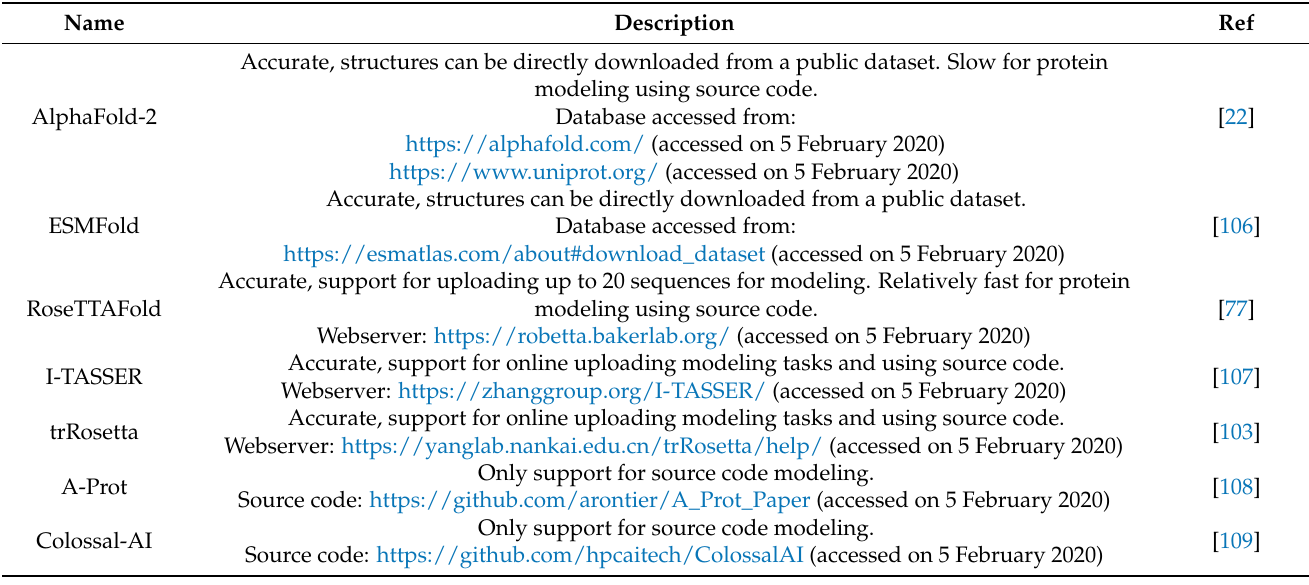
Table 3. AI-based protein modeling